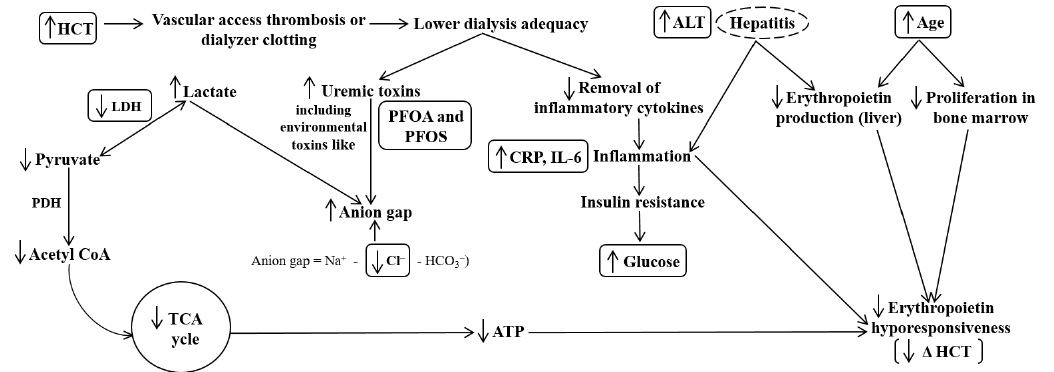
Figure 4. Schematic representation of possible mechanisms involving significant factors associated with erythropoietic response. Abbreviations: HCT, hematocrit; ALT, alanine aminotransferase; LDH, lactate dehydrogenase; PDH, pyruvate dehydrogenase; acetyl CoA, acetyl coenzyme A; TCA cycle, tricarboxylic acid cycle; ATP, adenosine triphosphate; PFOA, perfluorooctanoic acid; PFOS, perfluorooctane sulfonate; Na + , sodium; Cl − , chloride; HCO 3 − , bicarbonate; CRP, c-reactive protein; IL-6, interleukin- 6; Δ HCT, change in HCT level from phase 1 to phase 3 .